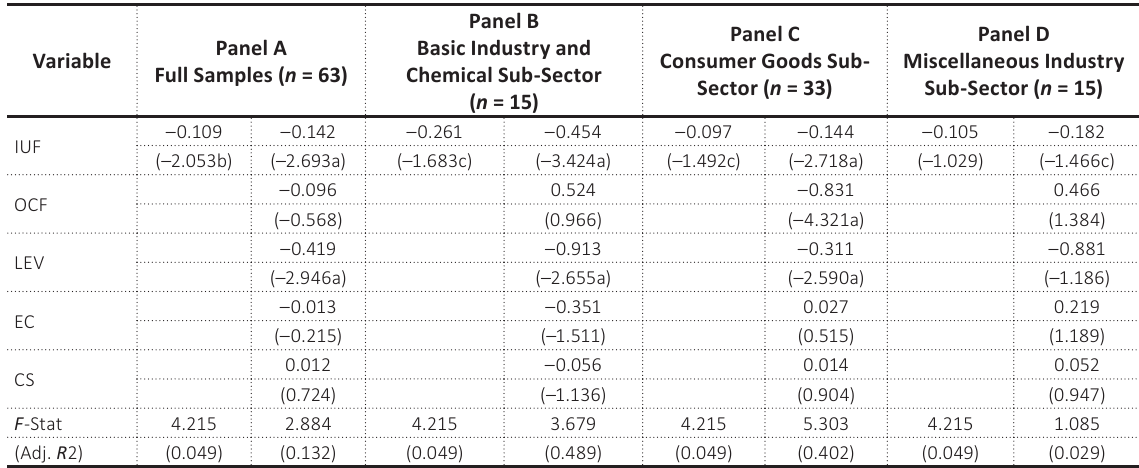
Table 3. Summary of statistical test